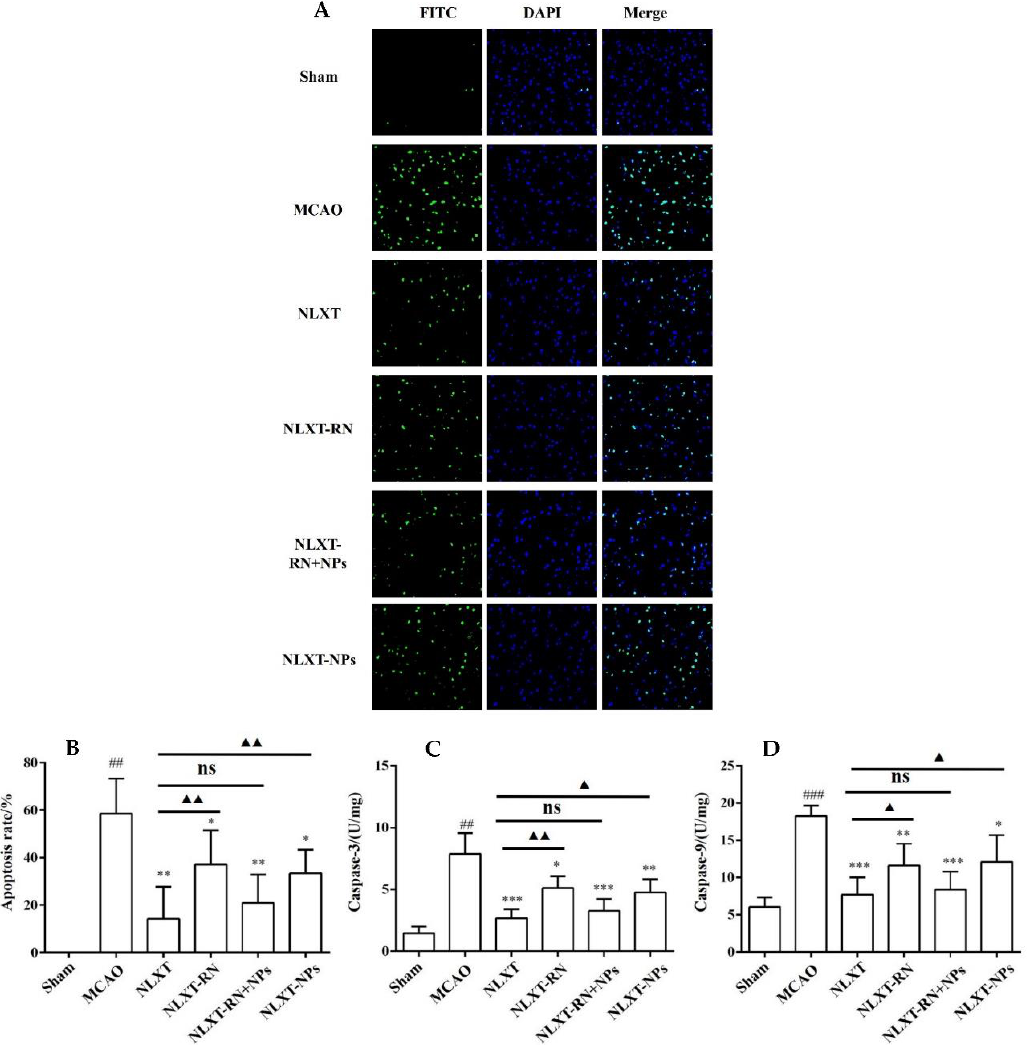
Figure 5. ( A ) The apoptosis of rat brain tissue after TUNEL staining was observed under 200-fold magnification (×200, n = 8). Effect of administration groups on the brain cells' apoptosis rate ( B ) and caspase-3/9 ( C , D ) level of MCAO rat models (n = 8). ## p < 0.01, ### p < 0.001, compared with sham group; * p < 0.05, ** p < 0.01, *** p < 0.001; compared with MCAO group; ns: no significant difference, ▲ p <0.05, ▲▲ p < 0.01, compared with NLXT group.